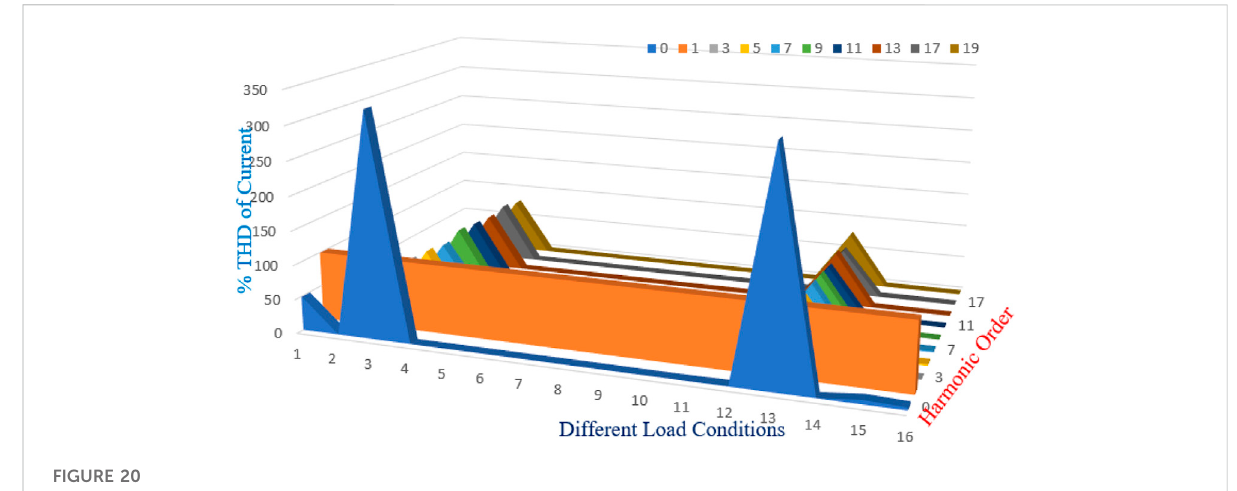
FIGURE 20 % THD of source current for different